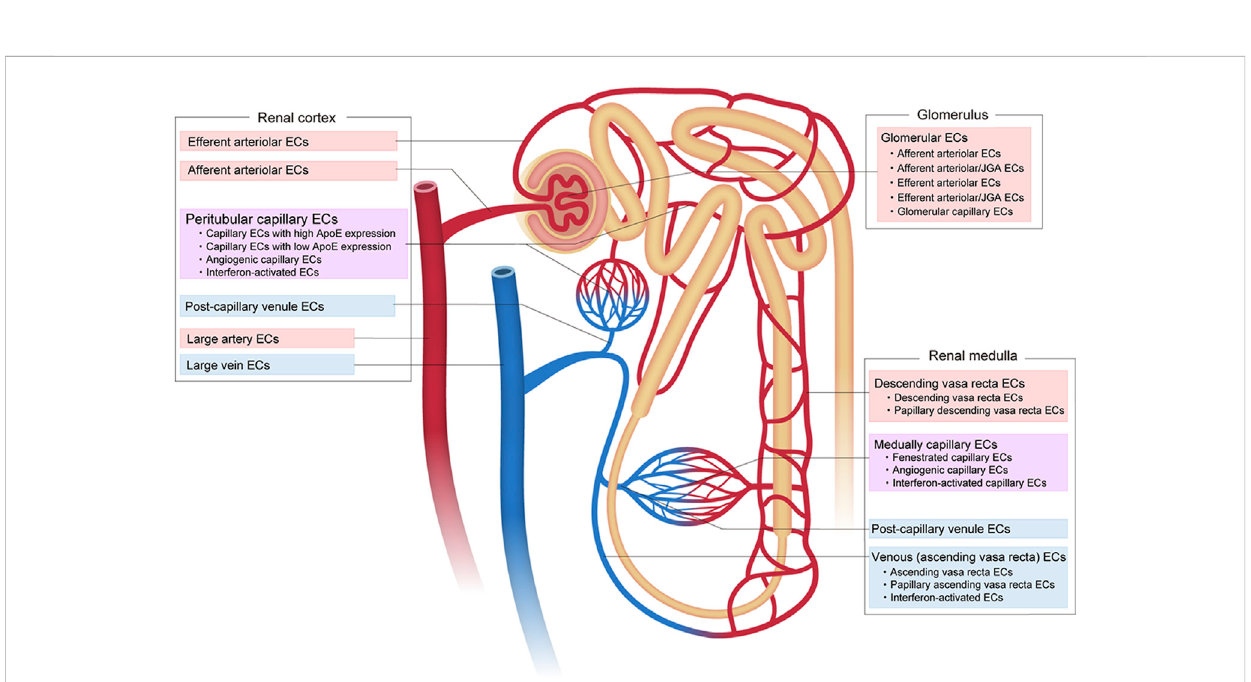
FIGURE 4 Vascular endothelial cell heterogeneity in the kidney. Vascular endothelial cells (ECs) in the kidney show diverse heterogeneity based on their structure, location, complex function, and molecular signature.